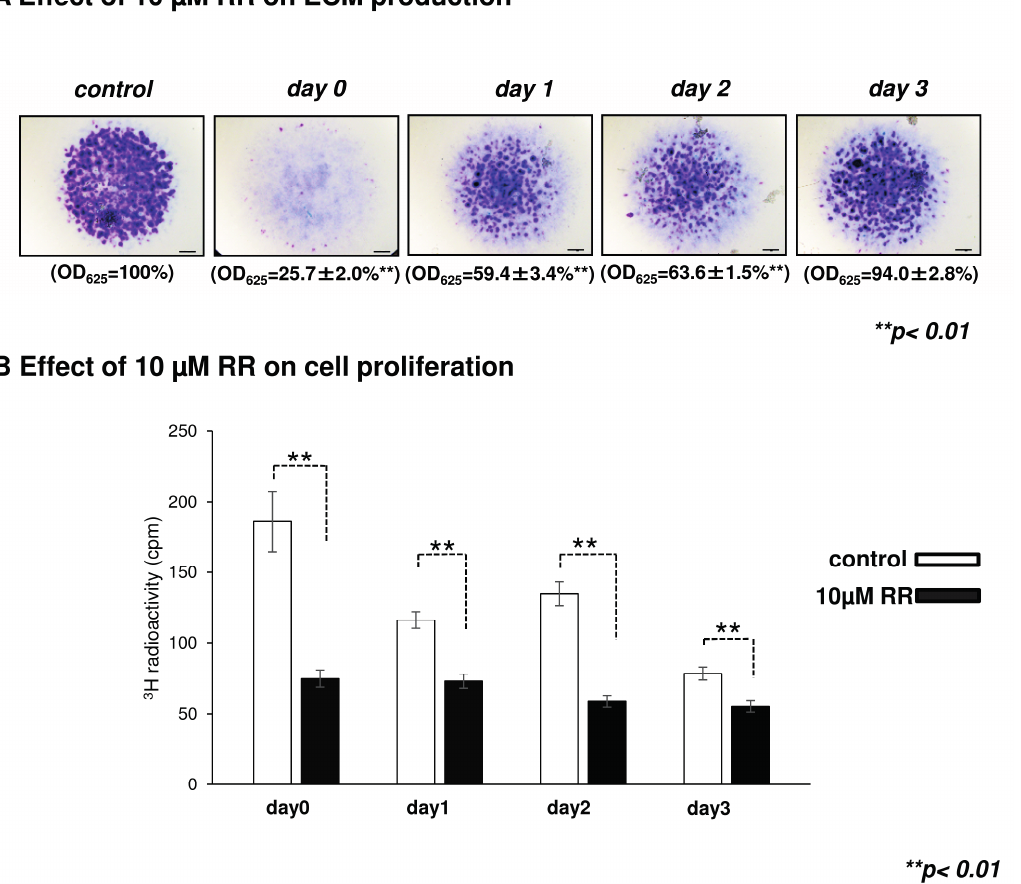
Figure 3. The effect of ruthenium red (RR) treatment on cartilage matrix production and cellular proliferation. ( A ) The cartilage matrix of six-day-old micromass cultures were stained with acidic dimethyl-methylene blue (DMMB) after treating the colonies with 10 µM RR for 24 h on days 0, 1, 2 or 3 of culturing. Representative photomicrographs out of four independent experiments are shown. Original magnification was 2×. Scale bar, 1 mm. Optical density (OD 625 ) was determined in samples containing toluidine blue (TB) extracted with 8% HCl dissolved in absolute ethanol. Data are expressed as mean ± SEM. Asterisks ( ** ) represent significant difference compared to control cultures ( ** p < 0.01). Displayed values are from one representative assay out of four independent experiments; ( B ) RR significantly decreased cellular proliferation rate ( 3 H-T) in chicken micromass cultures. Statistically significant differences are marked by asterisks ( ** p < 0.01). Data shown are from one representative experiment out of